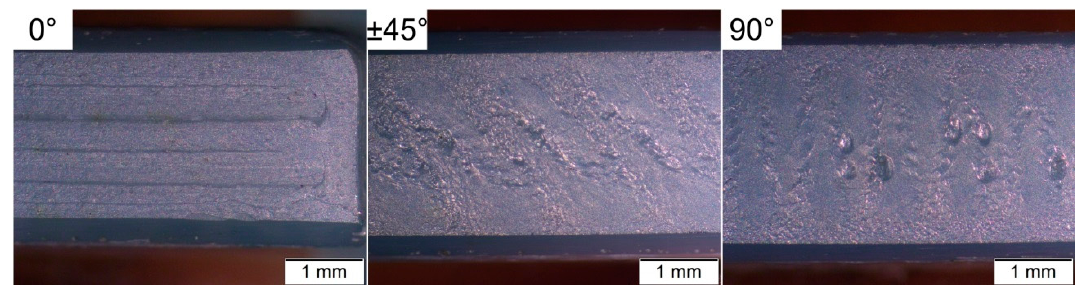
Figure 8. Underside of the sintered specimens produced with the different infill orientations after chamfering.